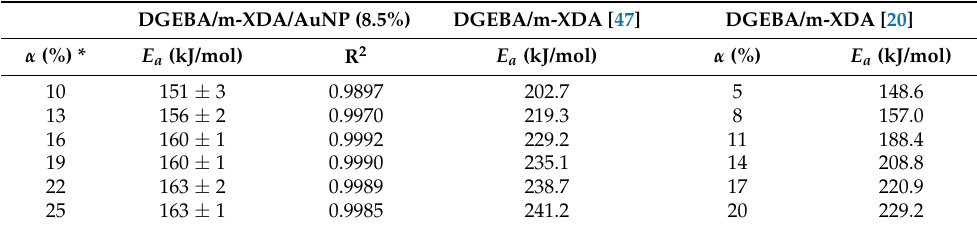
Table 5. Activation energies obtained by the Flynn–Wall–Ozawa method for DGEBA/m-XDA/AuNP (8.5%) and DGEBA/m-XDA [20,47]